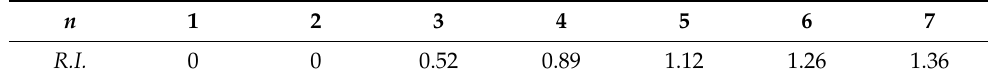
Table 2. Average random consistency